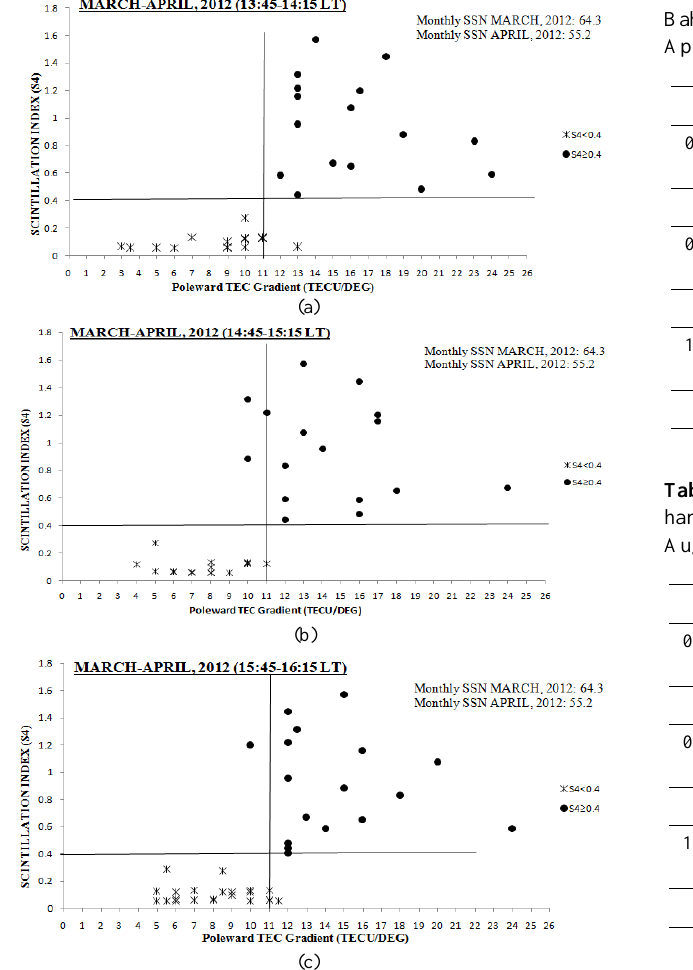
Table 2. 2 × 2 contingency table of the two stations (Calcutta,